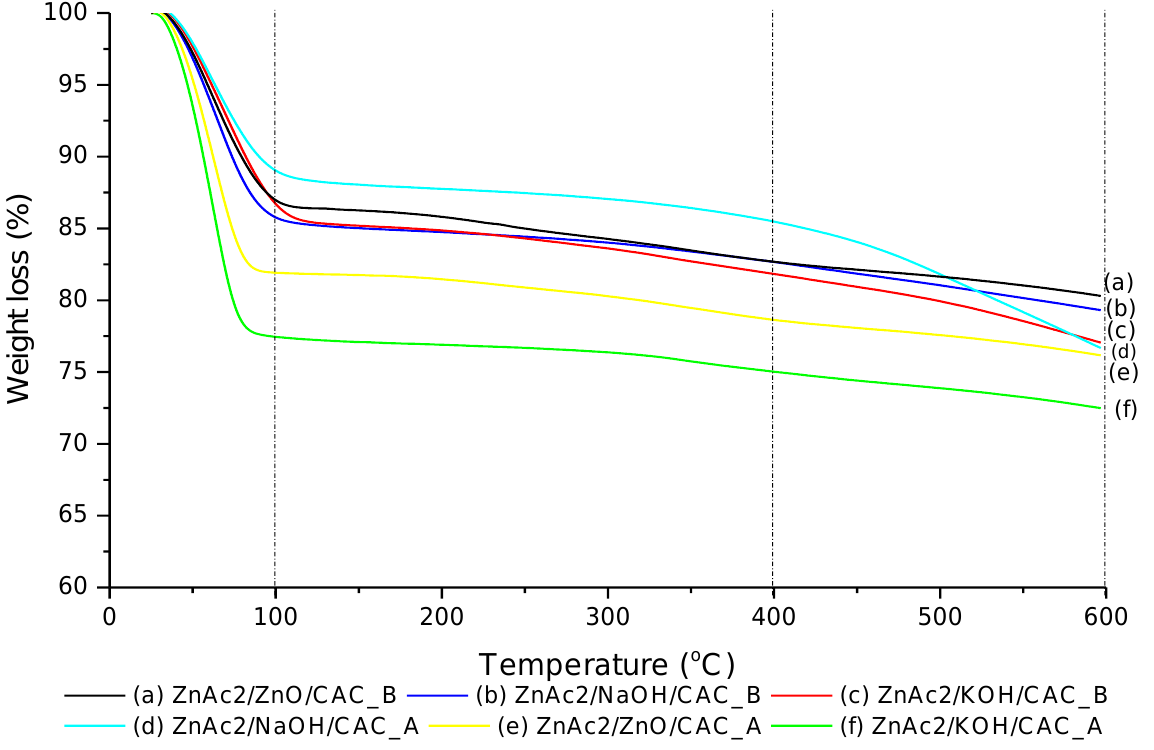
Figure 3. Thermogravimetric analysis weight loss curve.